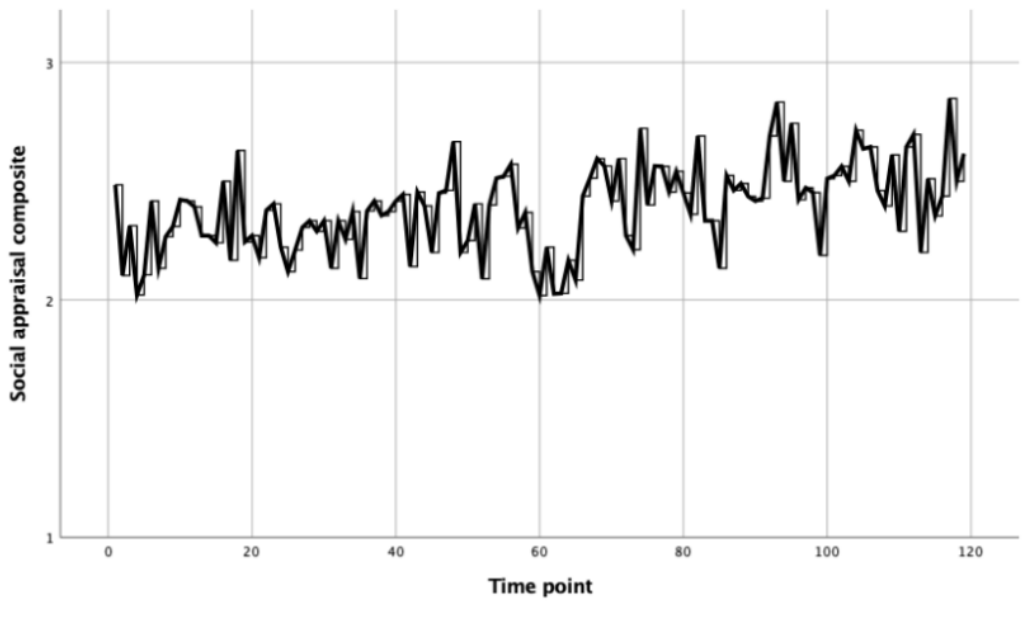
Figure 4. Changes in ecological momentary assessment-reported social appraisals during the intervention period.